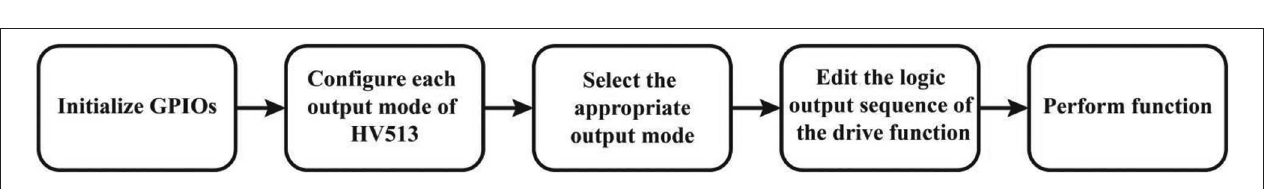
FIGURE 10 | System software flow chart. Each function is in the original standby state, and then, the system starts to configure the output mode of the HV513, which can be divided into three ways to execute the function. The first is to directly execute the original output sequence to complete the corresponding functions. The second is to switch to other output sequences by switching mode keys to perform corresponding functions. The third is to execute the serial program to perform the corresponding functions.